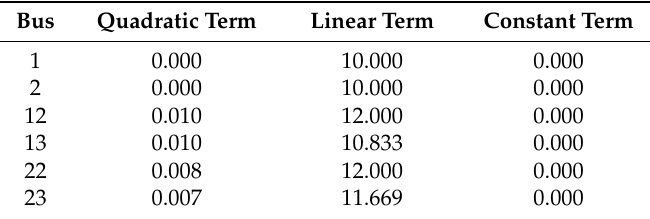
Table 3. Generators’ quadratic cost function coefficients.